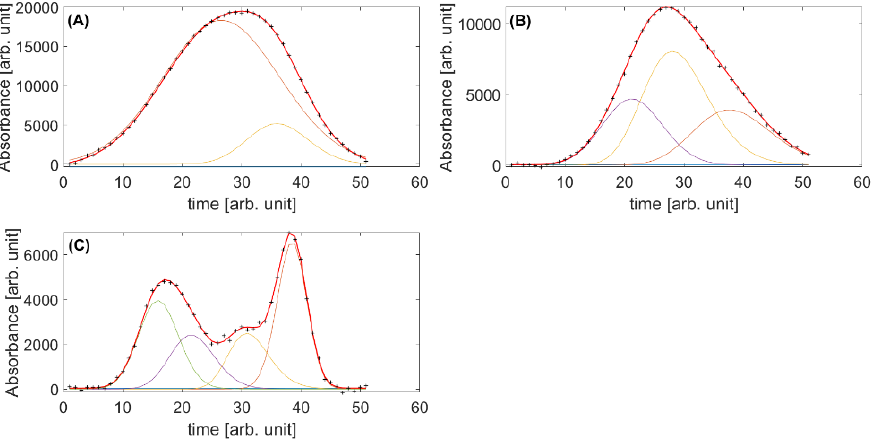
Figure 4. Deconvolution of the four components by itMPF with ( A ) D2nh, ( B ) D3nh and ( C ) D4nh.